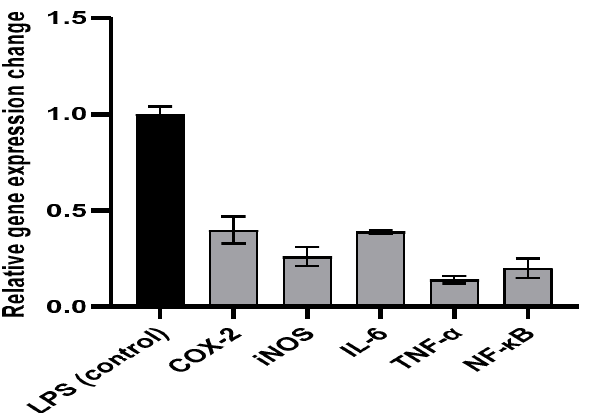
Figure 5. A chart representing the impact of APEE on the expression of the genes encoding COX-2, iNOS, IL-6, TNF- α , and NF- κ B in the LPS-induced PBMCs. The results are expressed as mean ± SD as the experiments were performed in three independent triplicates.